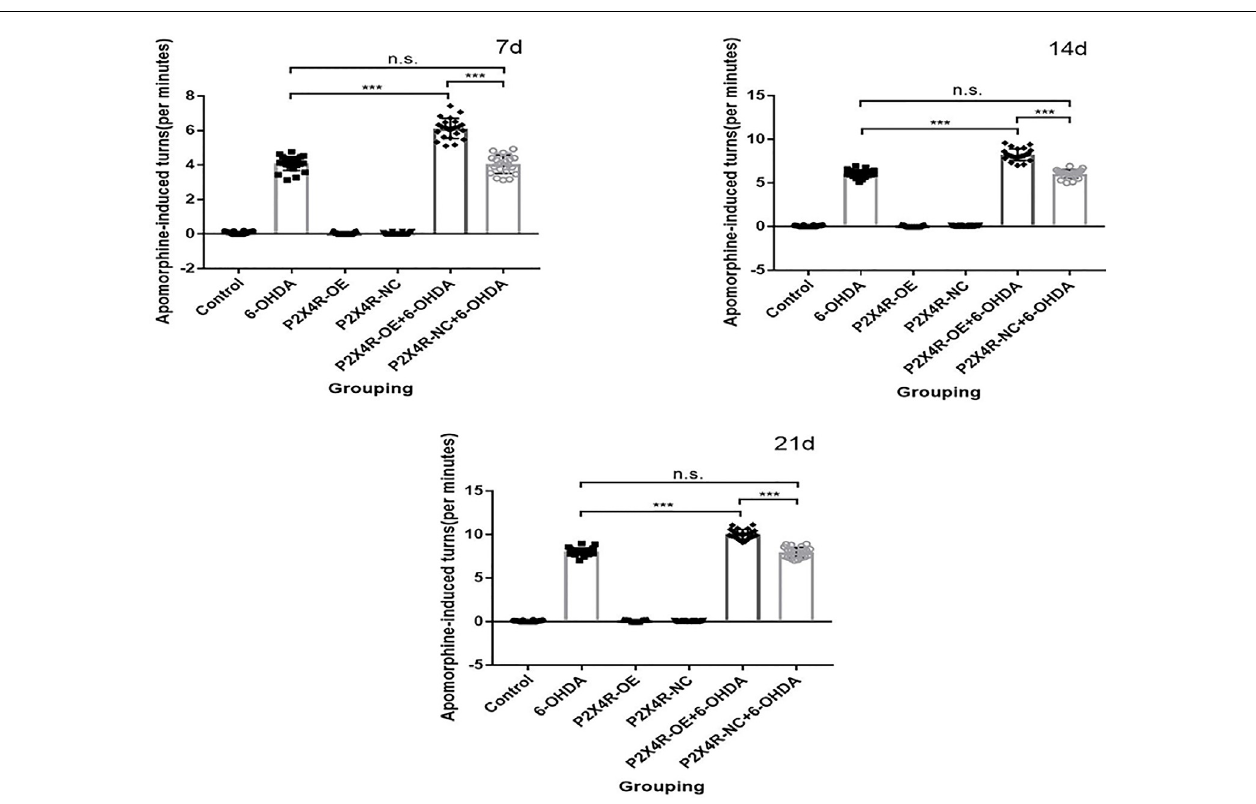
FIGURE 1 | Apomorphine-induced rotation tests at 7, 14, and 21 Days. *** p < 0.001. n.s.: there is no statistical difference between the two